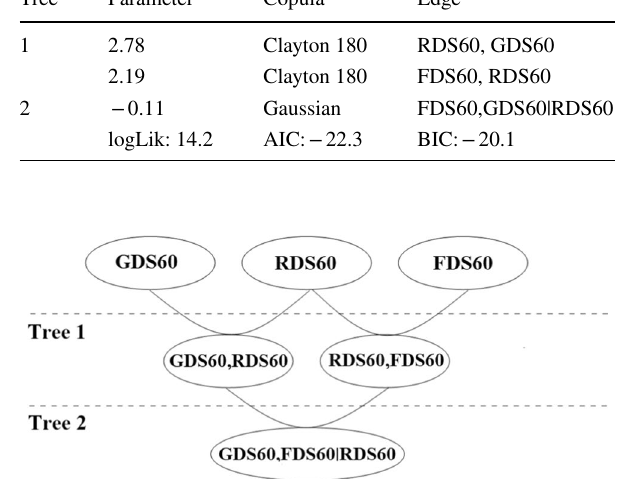
Fig. 9 Final tree of D-vine copula in three-dimensional structure analysis of groundwater level deficiency signature in Tapik basin